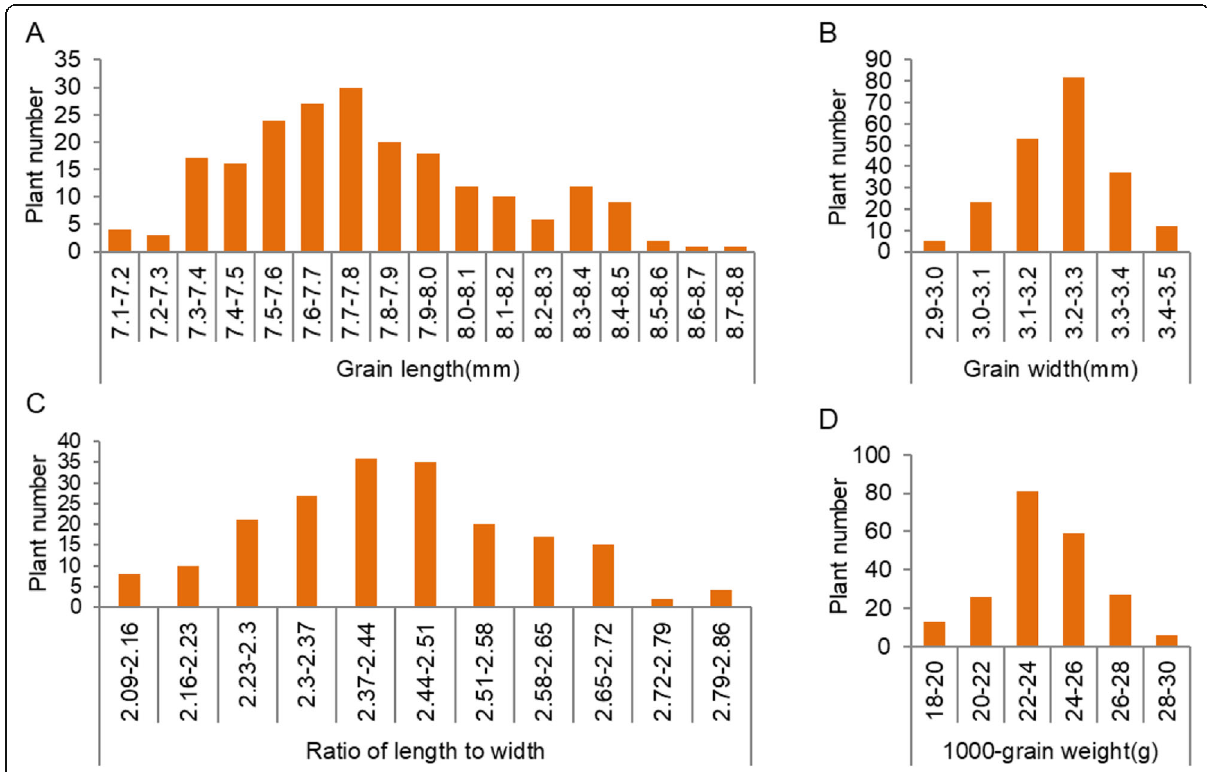
Fig. 4 Frequency distributions of grain size related traits in the F 2 population